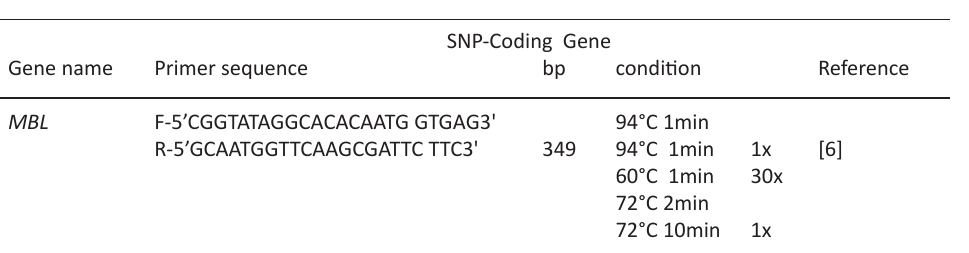
Table 1. Primer and PCR conditions for MBL 54 genotyping